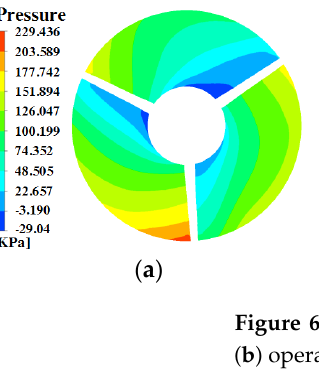
Figure 6. Pressure distribution on the middle section of the runner: ( a ) Operation condition 1; ( b ) operation condition 2; ( c ) operation condition